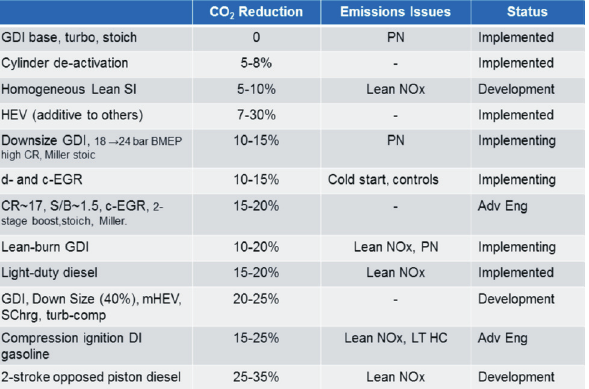
Fig. 3. Estimated CO emissions reductions, criteria pollutant issues, and 2 status for representative LD engine technologies